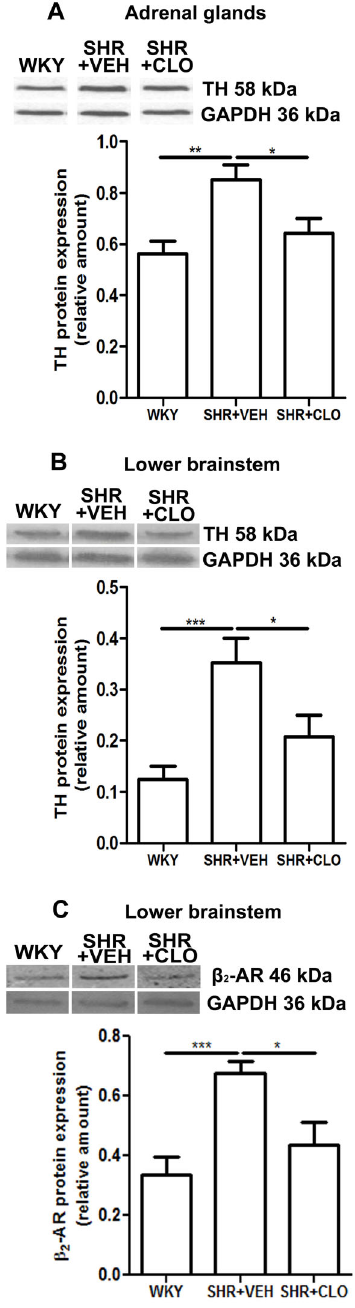
Figure 1. Protein expression levels of tyrosine hydroxylase (TH) in adrenal glands ( A ) and of TH ( B ) and b 2 -adrenergic receptor ( b 2 -AR) expression ( C ) in the lower brainstem using western blot analysis. GAPDH was used as an endogenous control for the normalization of relative protein expression. Data are reported as means ± SD for n=7 – 13 animals/group. *P o 0.05, **P o 0.001, and ***P o 0.0001 (one-way ANOVA). WKY: normotensive Wistar Kyoto rats; SHR: spontaneously hypertensive rats; VEH: vehicle; CLO: